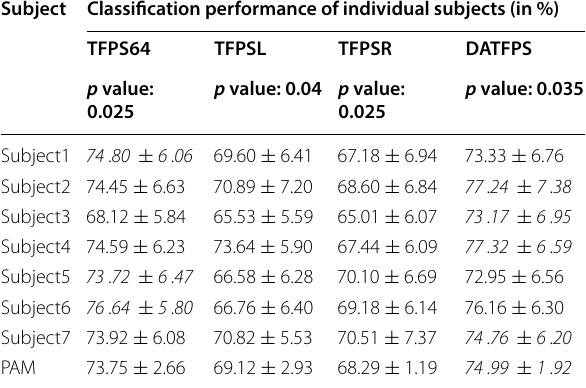
Table 2 Average classification accuracy ( deviation) for each feature